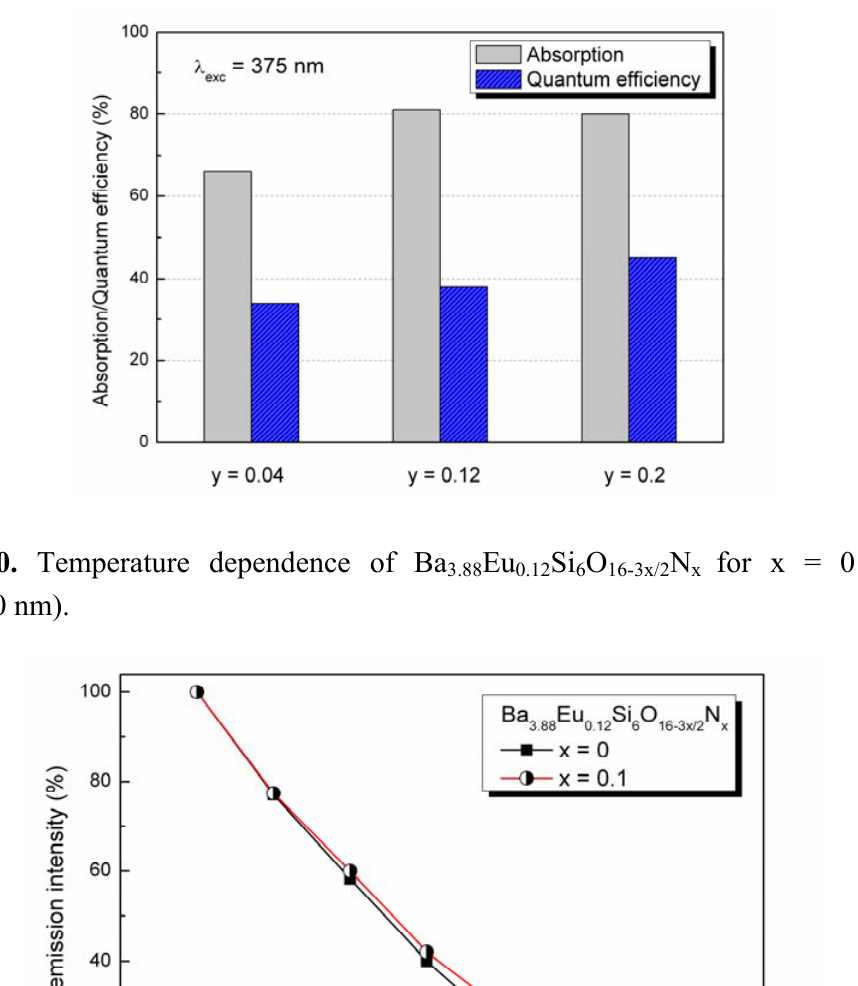
Figure 9. Quantum efficiency of Ba (y = 0.04, 0.12, 0.2).